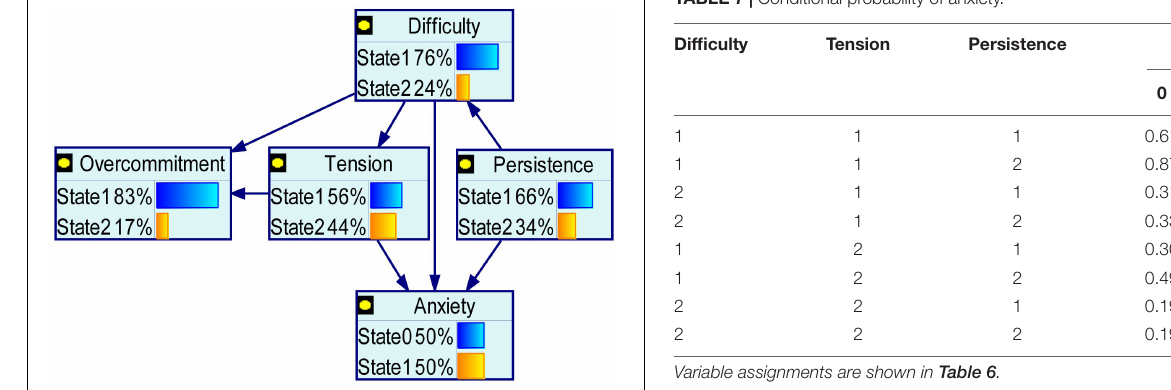
TABLE 7 | Conditional probability of anxiety.